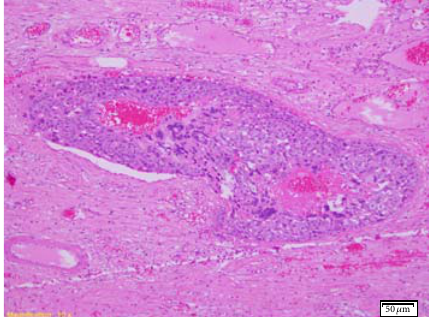
Figure 2: Entire tumour composed of choriocarcinoma char- acterised by an admixture of syncytiotrophoblastic and cytotro- phoblastic